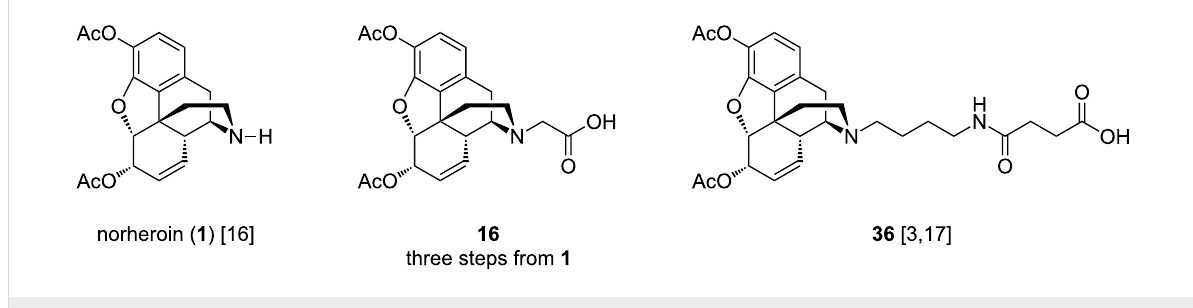
Figure 3: Heroin intermediates used to synthesize HF-1 through HF-9 .